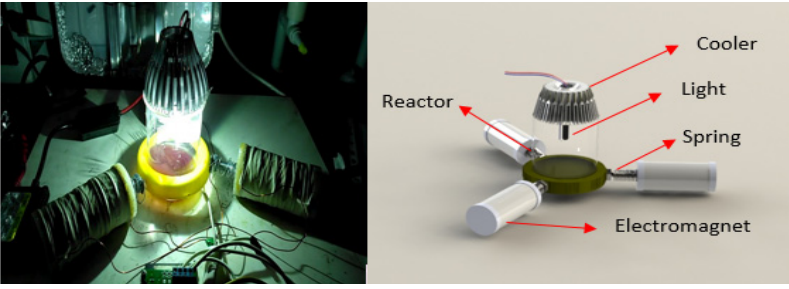
Fig. 3. Image of Photocatalytic Reactor and its Schematic